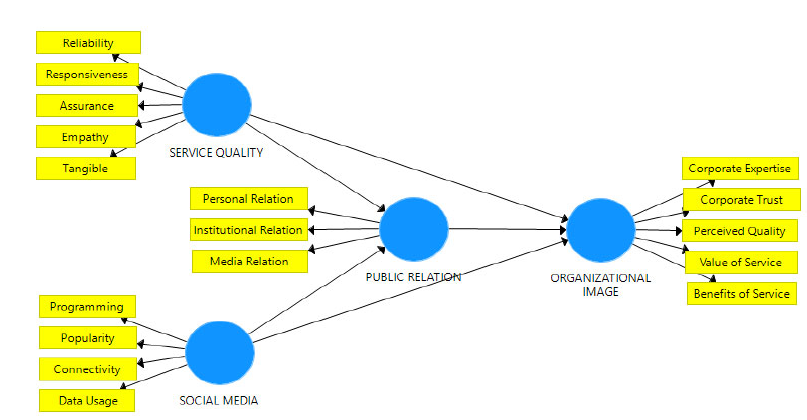
Fig. 1. The Research Framework of Organizational